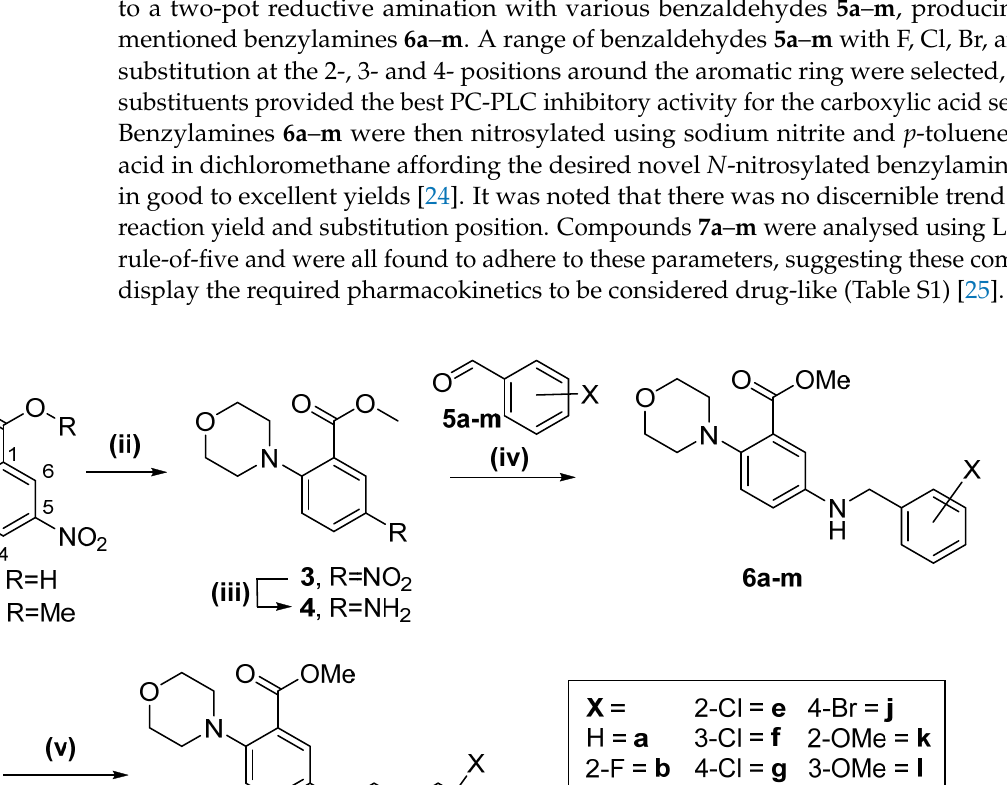
Figure 1. Structures of D609 (left) and 2-morpholinobenzoic acids (centre) compared to N -nitrosylated benzylamines (right) investigated in this study. X = H, F, Cl, Br,